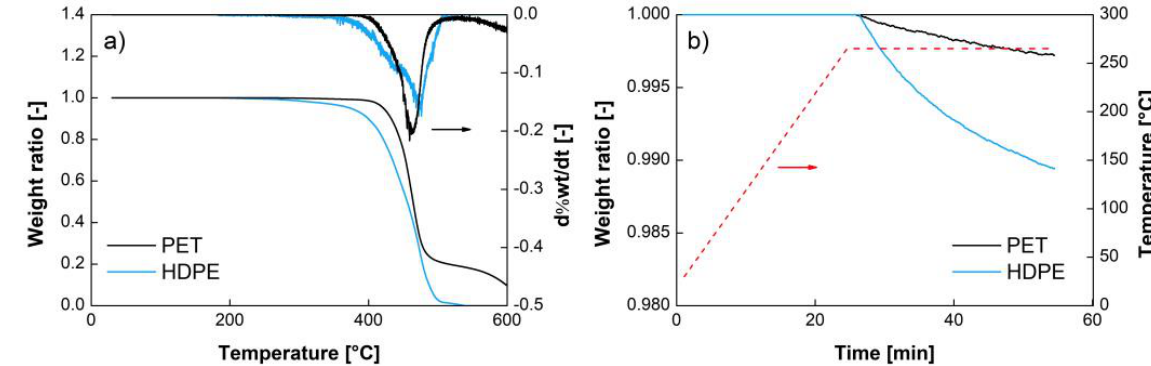
Figure 1. TGA and its derivatives of extruded PET and HDPE at 10 °C/min ( a ) and at 265 °C ( b ).